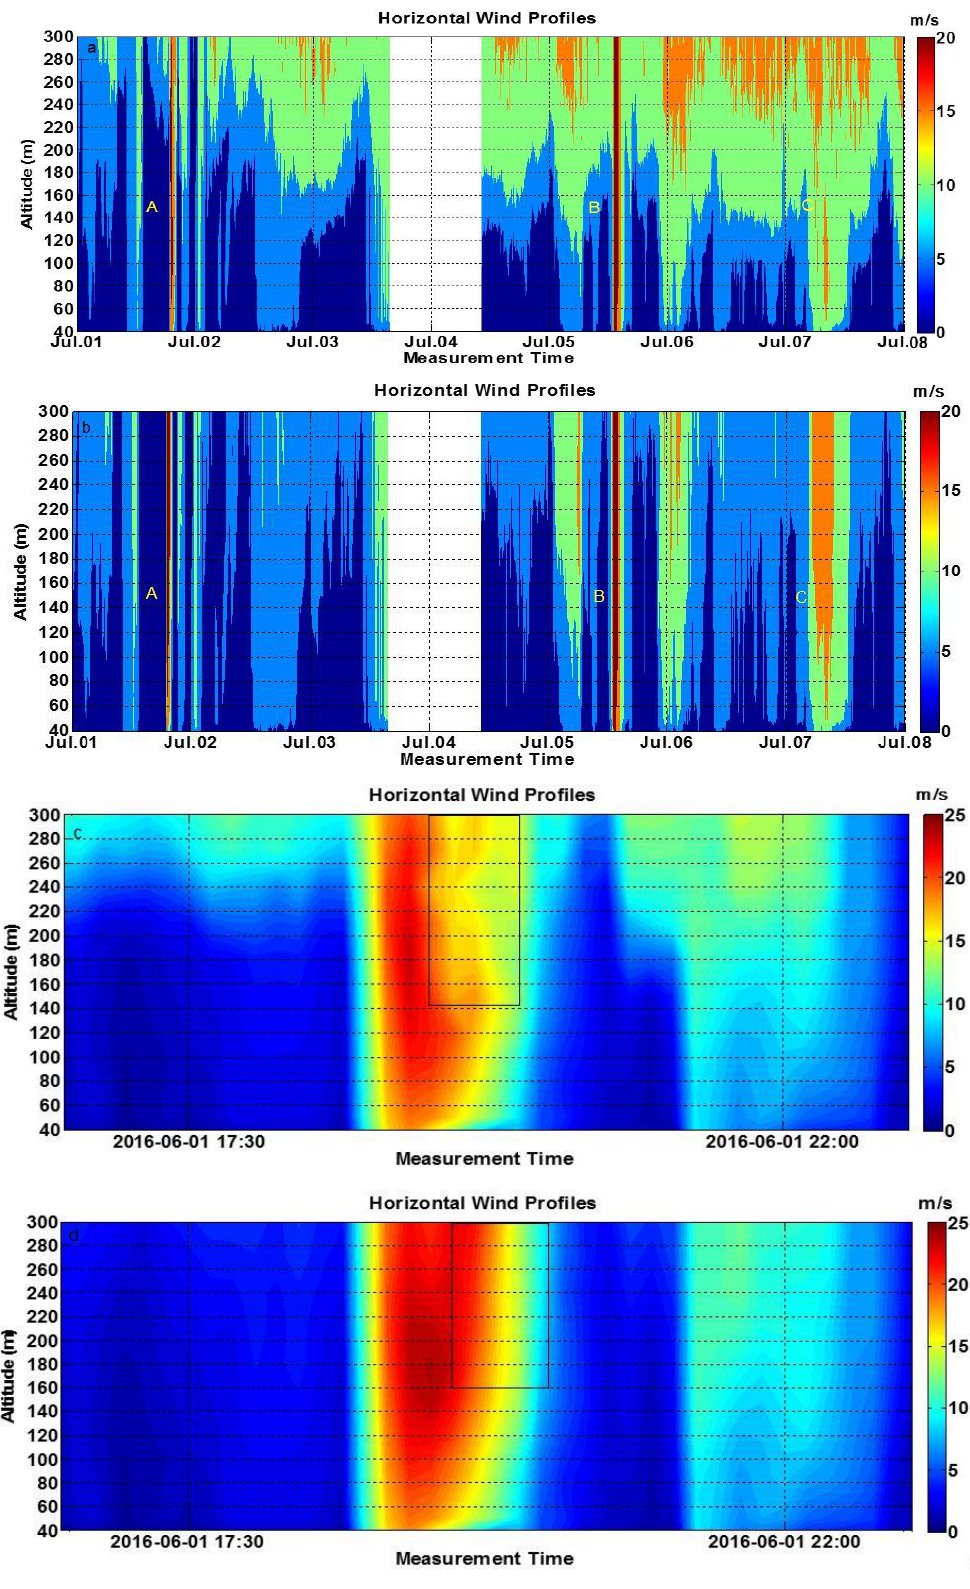
1 Figure 12. Horizontal wind speed of CWL. Horizontal wind velocity: ( a ) inverted from COG; ( b ) inverted from CR-CFAR; ( c ) during sandstorm A inverted from COG; and ( d ) during sandstorm A inverted from